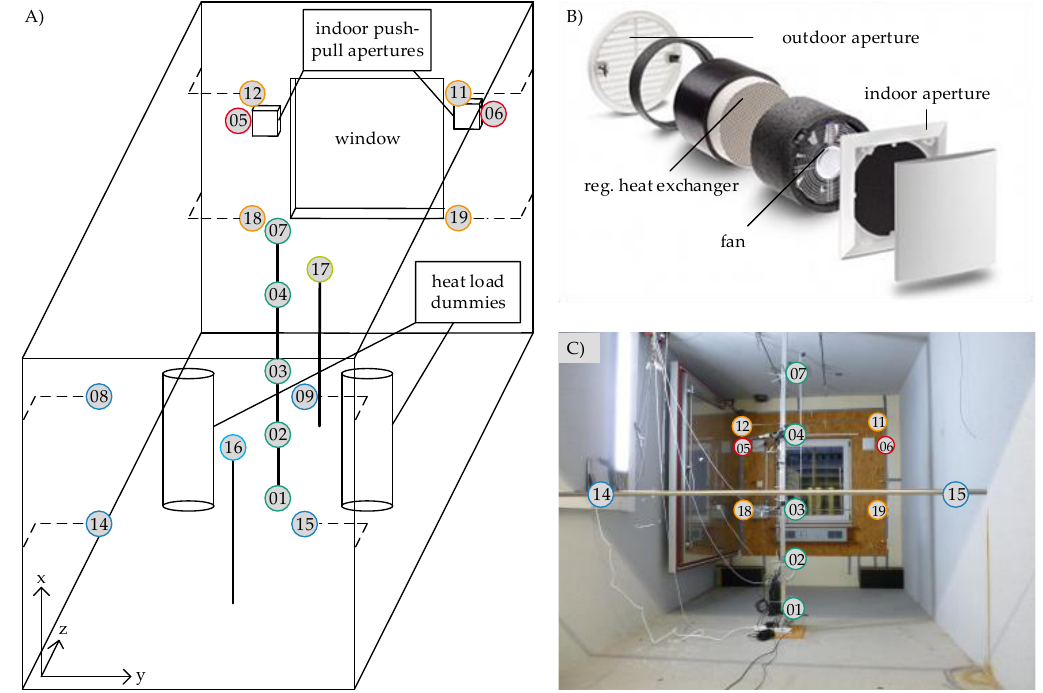
Figure 4. ( A ) Sketch: Position of the sensors in the ICC, 2.77 m × 2.70 m × 5.00 m, ( B ) Exploded view Lunos e 2 [35], ( C ) Photo of the measurement setup with some of the sensors installed and the passive house façade-model installed between the ICC and ECC.